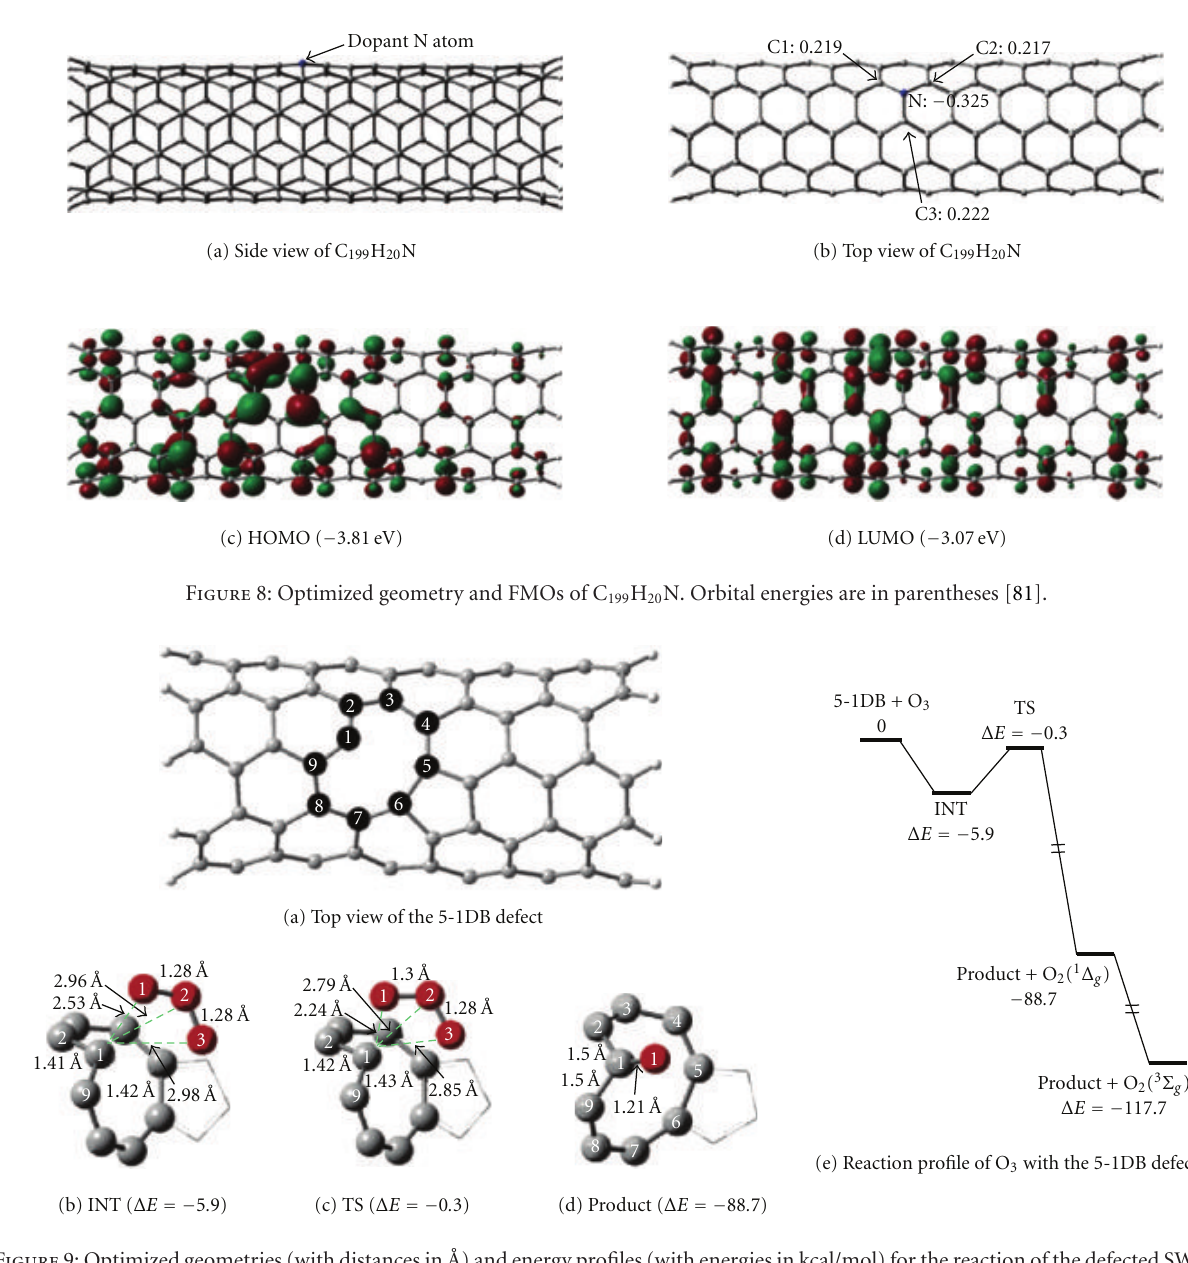
Figure 9: Optimized geometries (with distances in ˚A) and energy profiles (with energies in kcal/mol) for the reaction of the defected SWCNT with O 3 [111]. Legend: dark grey = carbon, light grey = hydrogen, red = oxygen. Table 1: Binding energy and geometric data for main group element-doped SWCNTs